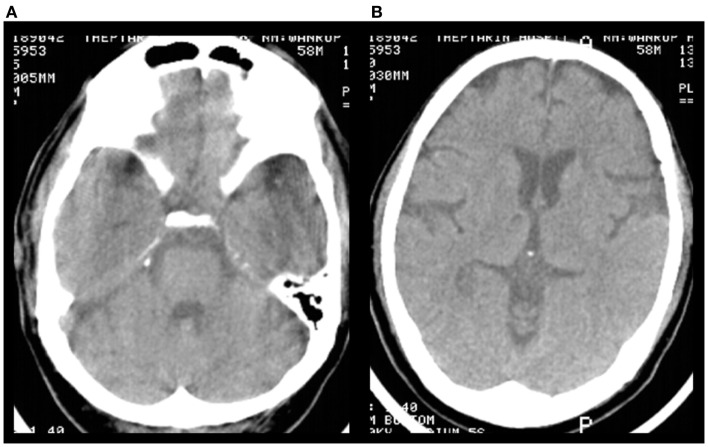
Pre-treatment non-contrast brain CT scan. (A,B) There was no evidence of acute ischemic or hemorrhagic stroke.